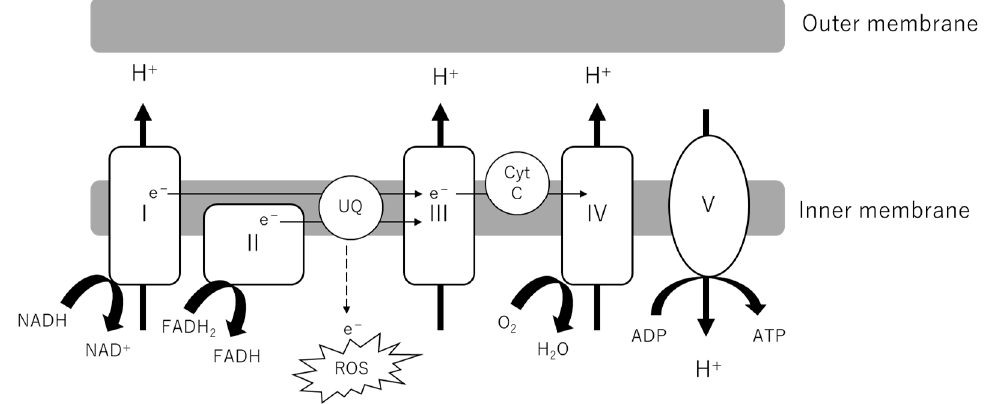
Figure 2. Electron transport chain (ETC) in mitochondrial inner membrane. NADH and FADH 2 from the TCA cycle donate electrons to Complexes I and II. As electrons are transported through the ETC, a proton gradient is generated, which Complex V or ATP synthase couples to ATP synthesis. Electron leakage from the ETC causes the production of ROS. ADP, adenosine diphosphate; ATP, adenosine triphosphate; Cyt C, cytochrome complex; ROS, reactive oxygen species; UQ, ubiquinone; TCA cycle, tricarboxylic acid cycle.